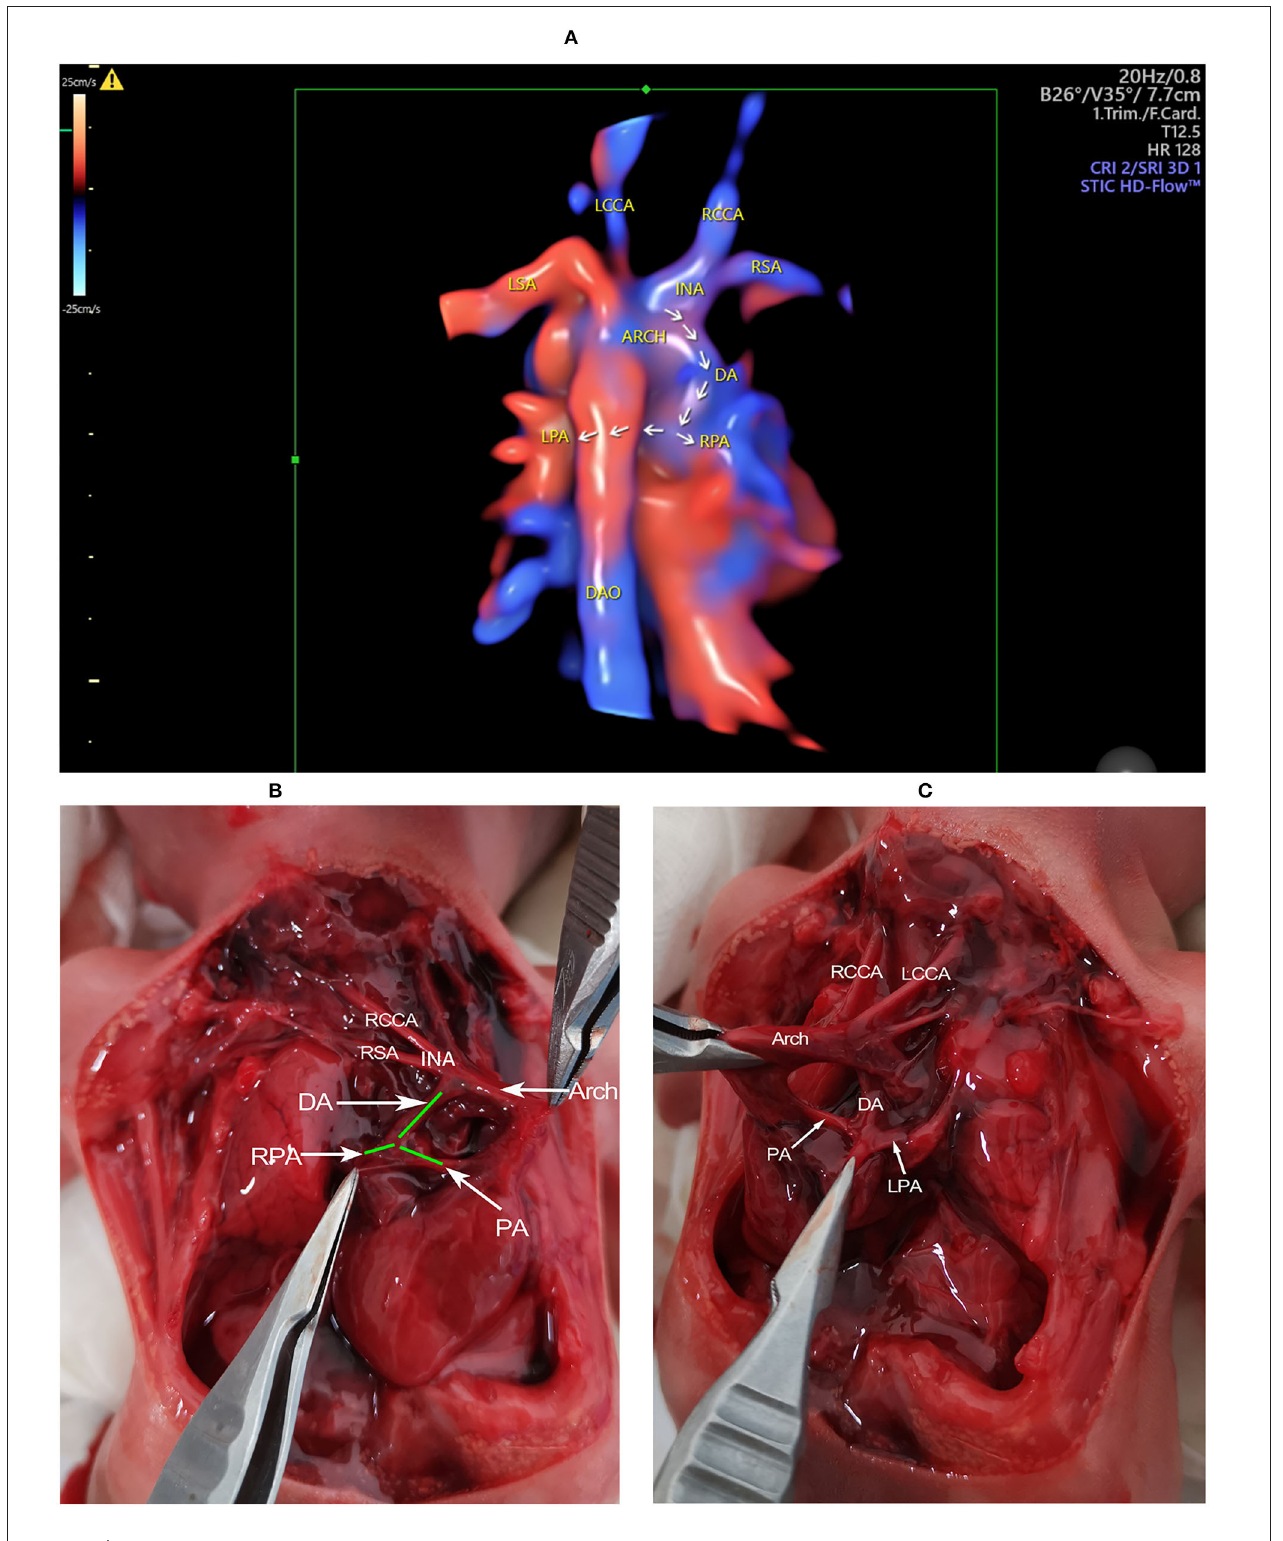
FIGURE 3 | The 3D reconstructed image and gross findings. (A) The 3D reconstructed image showing the spatial relationship of the related great vessels. The aberrant DA connects the base of the innominate artery with the pulmonary artery. The course of the DA, the LPA, and the RPA is indicated by arrows. (B) The heart is in the right hemithorax with the apex pointing to the right. The aortic arch is on the left of the trachea. The DA is visualized connecting the base of innominate artery